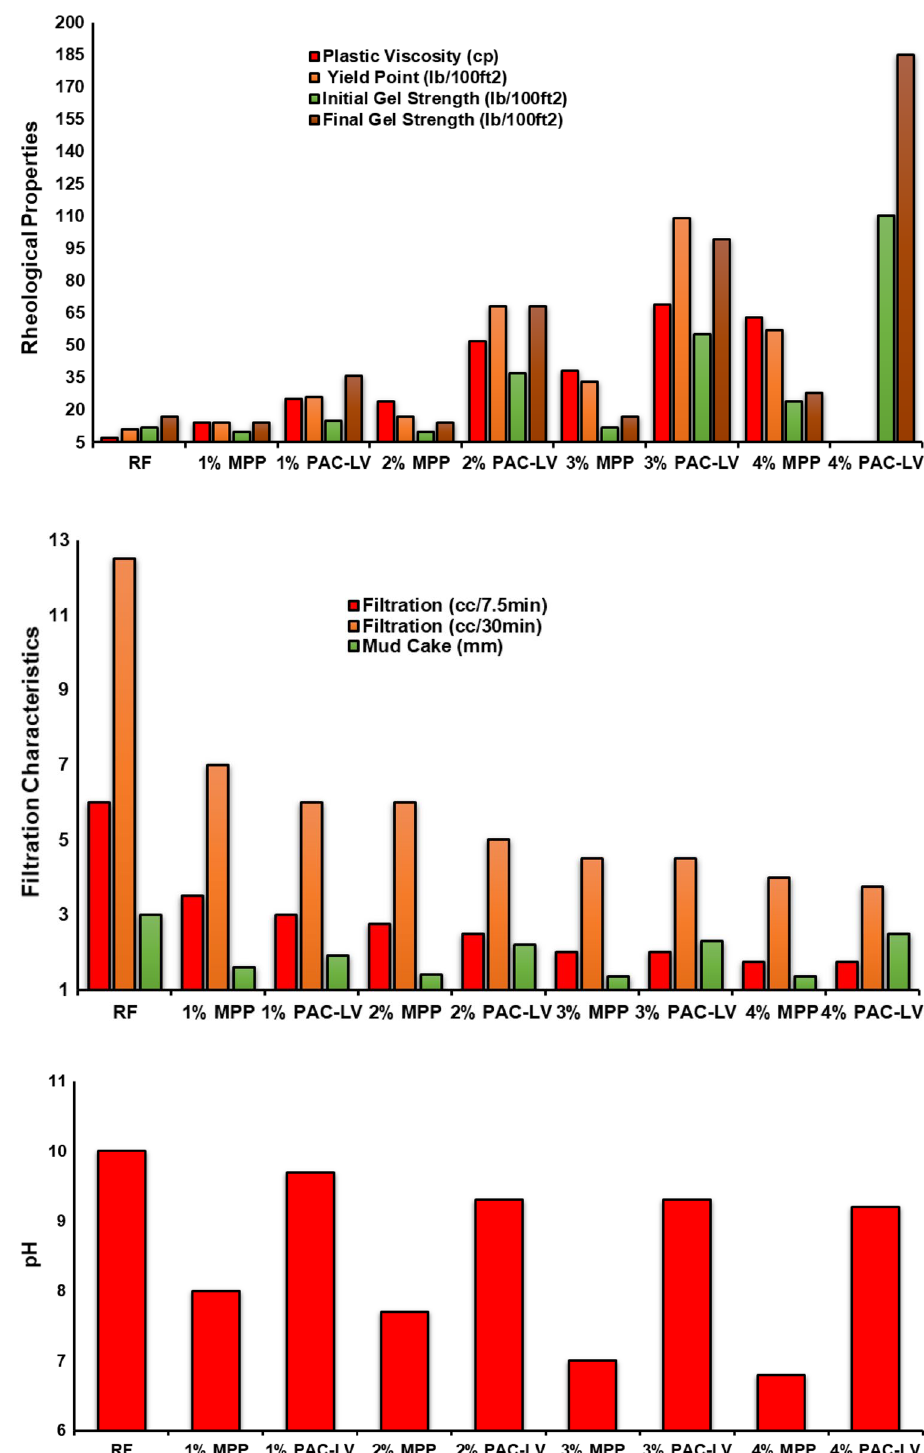
Fig. 10 The effect of MPP and